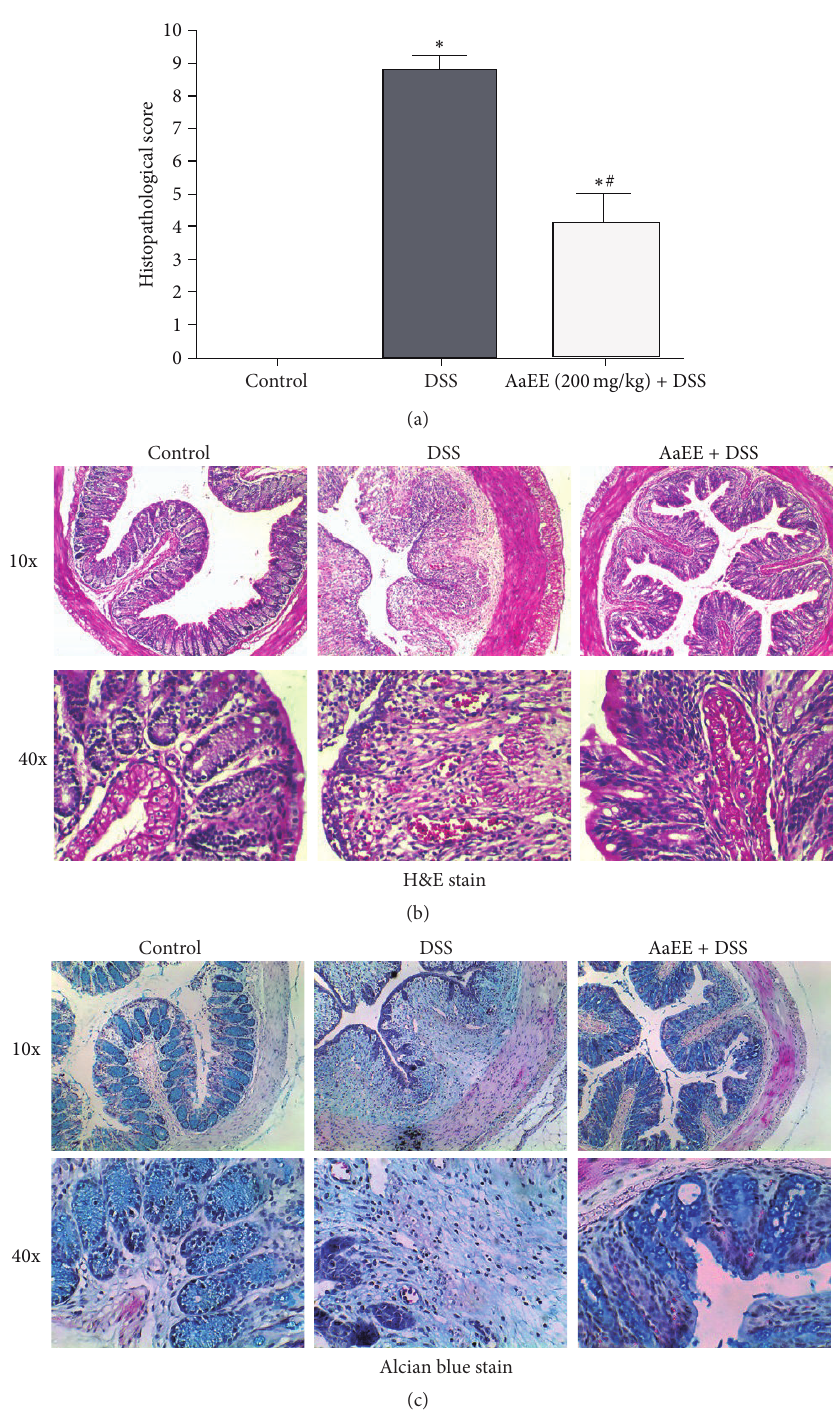
Figure 3: AaEE treatment improves the histopathological score in DSS-induced colitis mice. Mice colons were obtained at 10 days after DSS administration and were stained with H&E and Alcian blue. H&E and Alcian blue staining were performed on colon sections obtained from mice belonging to the control group (no DSS), DSS-treated (4% DSS), and AaEE (200 mg/kg) + DSS. Histopathological scores were analyzed from slides (a). Data from 3 independent experiments is shown and expressed as the mean ± SD ( 𝑛 = 6 per group). ∗ 𝑃 < 0.05 versus control; # 𝑃 < 0.0 5 versus DSS. Images were obtained at 10 and 40x magnification (b and